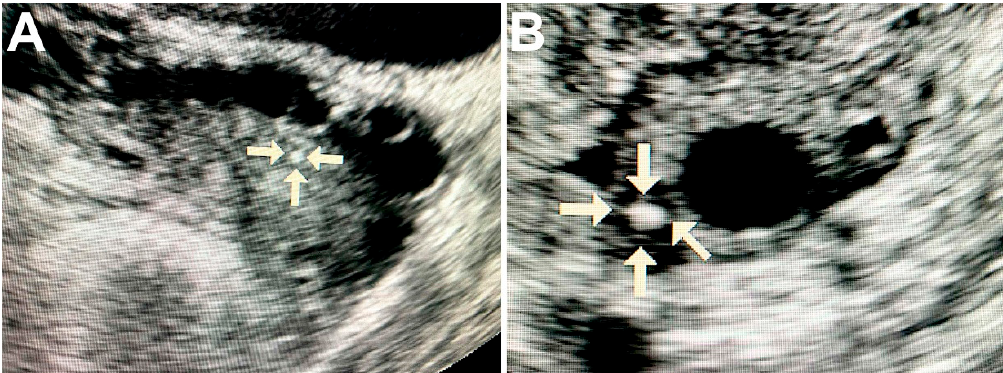
Figure 1. Ultrasound image of the ovary with pathological calcifications (marked by arrows). A —rounded biomineral structure in ovarian cancer tissue; B —the calcification is surrounded by cancerous tissue with cyst formation. Table 1. Ovarian tumors with calcifications. Clinical, macroscopic and ultrasound data are summarized in Table 1.